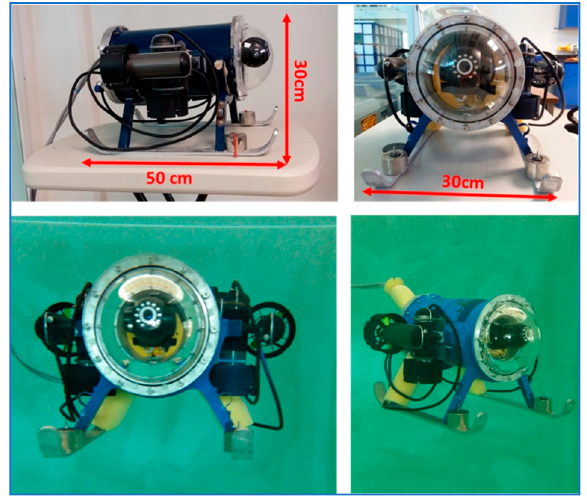
Figure 5. Small-sized sub-actuated underwater ROV used for the experiments.